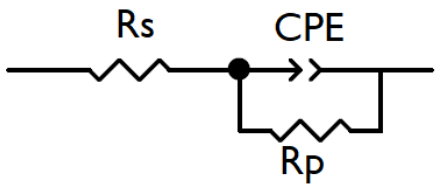
Figure 2. The equivalent electrical circuit for fitting and simulating the EIS data.